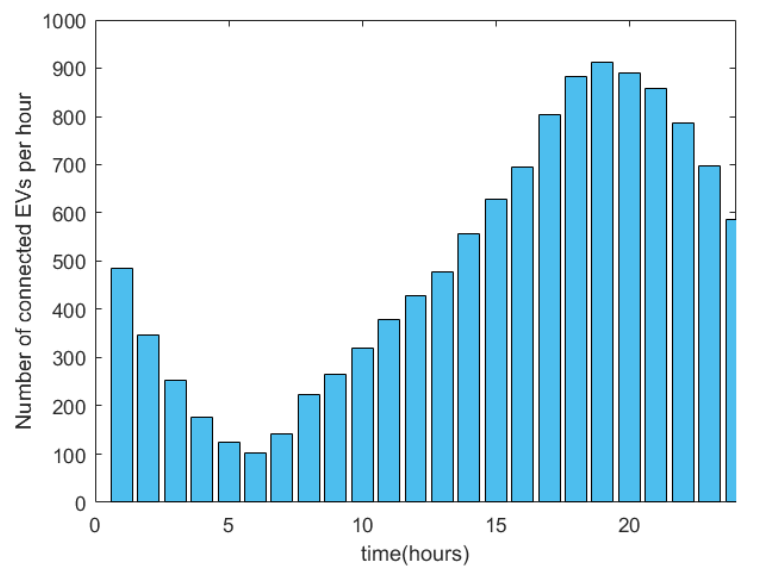
Figure 8. Number of connected EVs. The time series of the power generation of Photovoltaics (PVs) and Wind Turbines (WTs) are shown in Figure 9.